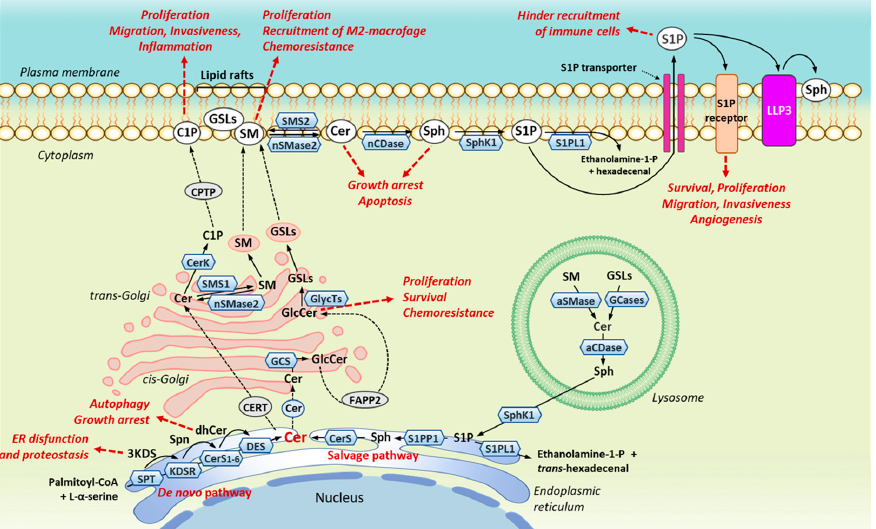
Figure 2. Cellular localization of sphingolipid metabolic enzymes primarily altered in breast cancer and biological effects on tumor cells. Abbreviations: aCDase, acid ceramidase; aSMase, acid sphingomyelinase; Cer, ceramide; CerK, ceramide kinase; CerS1-6, (dihydro)ceramide synthase 1-6; CERT, ceramide transfer protein; C1P, ceramide-1-phosphate; CPTP, ceramide phosphate transfer protein; DES, dihydroceramide desaturase; dhCer, dihydroceramide; FAPP2, phosphatidylinositol- 4-phosphate adaptor protein 2; GCS, glucosylceramide synthase; GlcCer, glucosylceramide; GSLs, glycosphingolipids; 3KDS, 3-ketosphinganine; KDSR, 3-ketosphinganine reductase; LPP3,